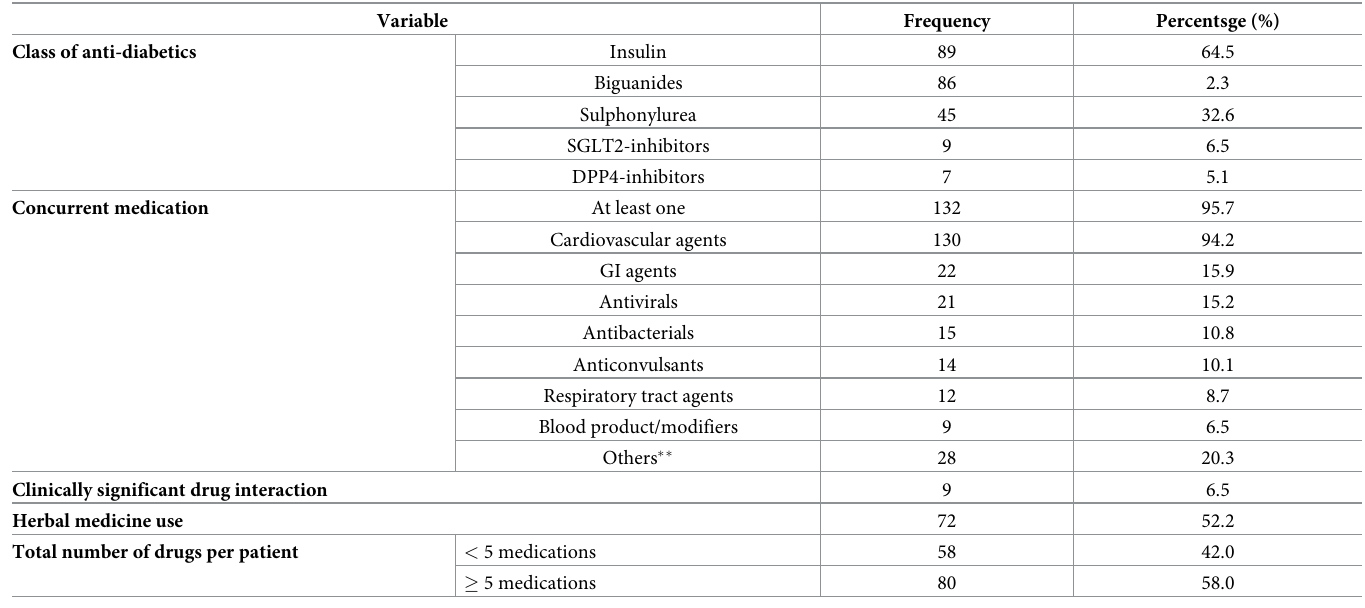
Table 3. Medication related factors among T2DM patients at medical and surgical wards of MRRH from November 2021 to January 2022, Mbarara, Uganda.